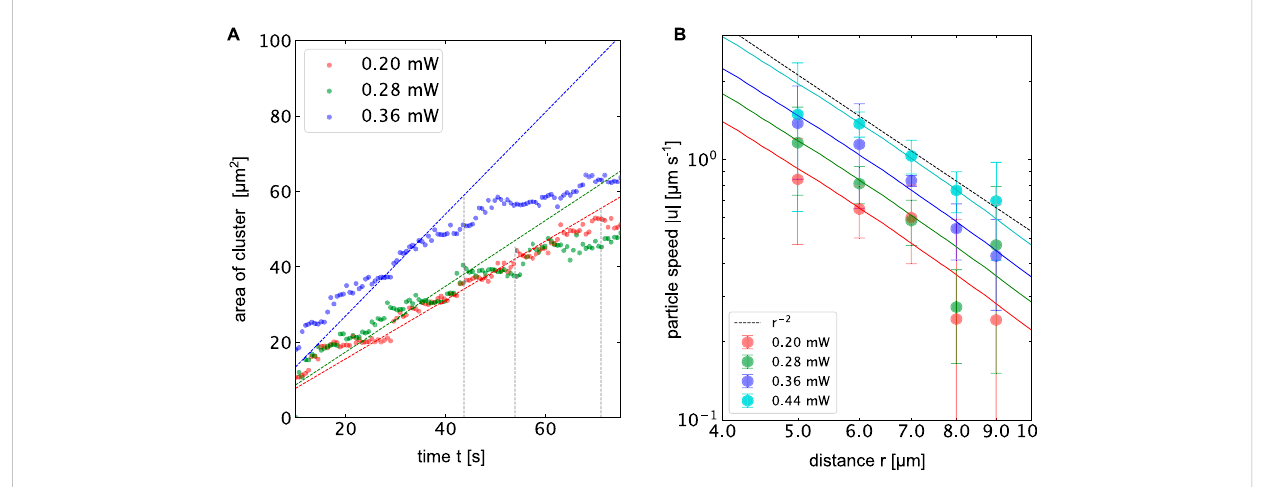
FIGURE 6 (A) Area of the colloidal crystal made of 512 nm PS beads over time in the presenence of 5 % PEG at different heating powers corresponding to Δ T max = 3.66 K, 5.12 K and 6.6 K. The dotted lines indicate growth laws, where the radius of the cluster growth with the growth rate. The vertical lines indicate the times at which a second layer starts to form on the fi rst layer. (B) Radial particle speed magnitude | u | as a function of the in-plane distance r from the heat source. The symbols indicate the experimental speed at different heating powers. The solid lines correspond to the temperature gradient along the gold surface as obtained from the numerical simulations (Figure 2C) and scaled by some constant factortomatchtheexperimentaldata.Thedashedlineshowsa r − 2 lawvalidforthetemperaturegradientobtainedforapointheatsourceforcomparison. Note that the speeds are negative, i.e., directed towards the hot spot.